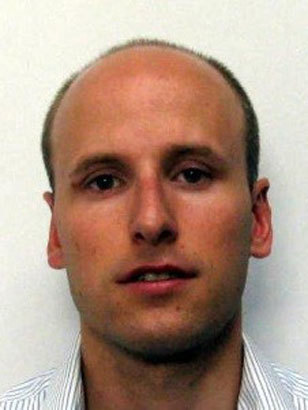
Michael Aertsen